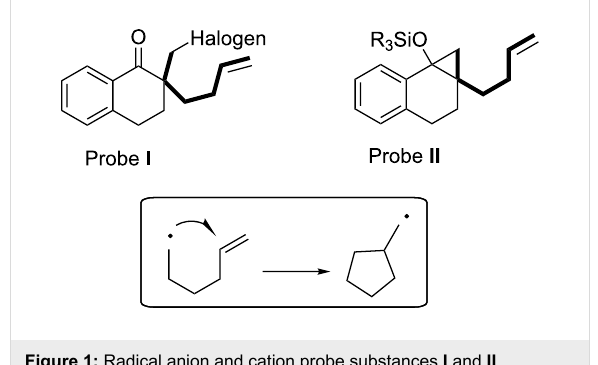
Figure 1: Radical anion and cation probe substances I and II , possessing 5-hexenyl structures.